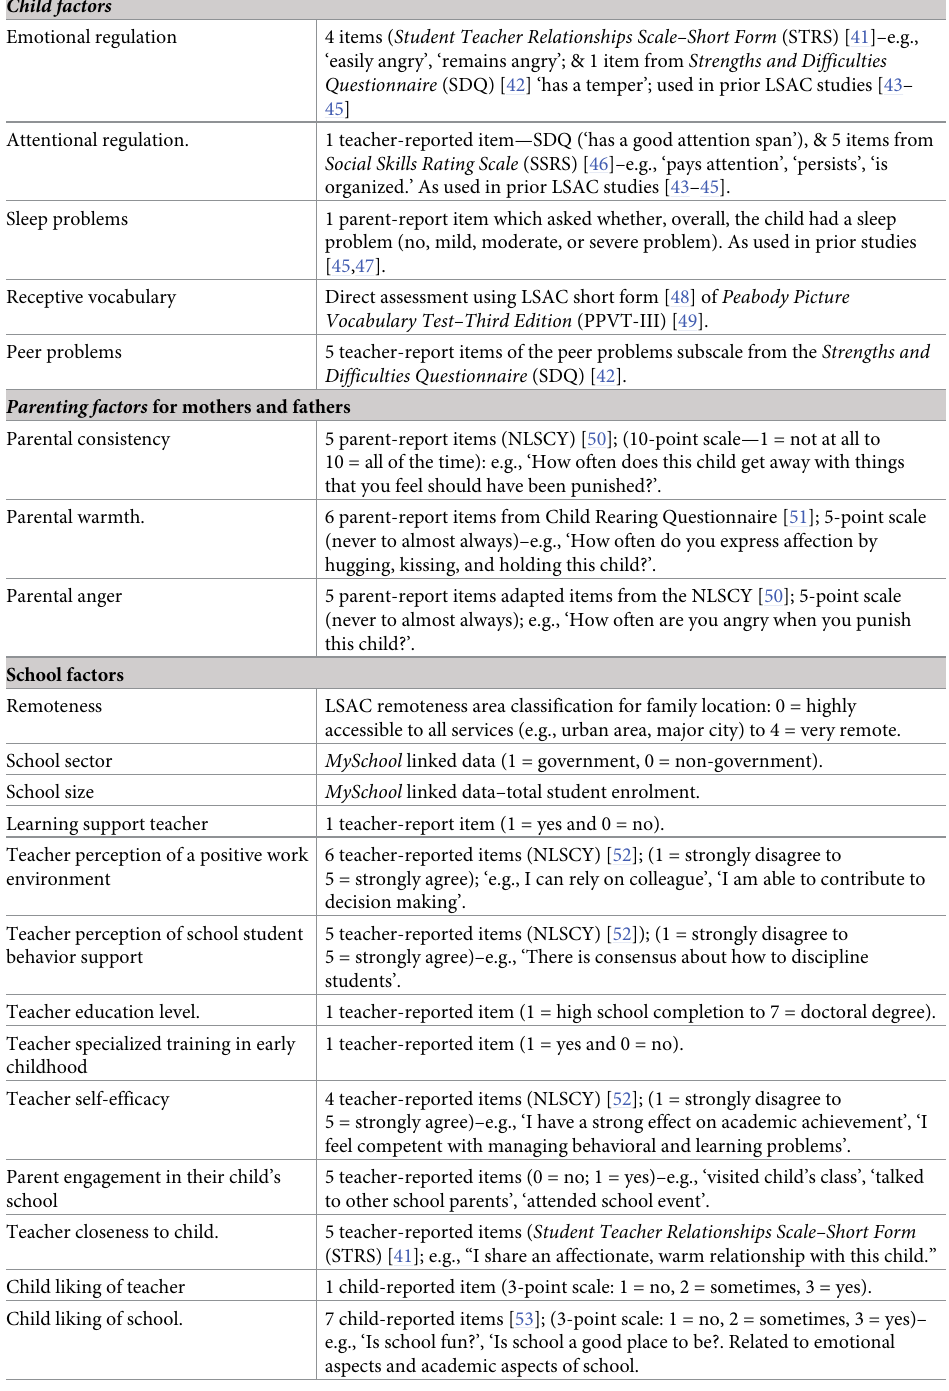
Table 2. Variables used to explain academic